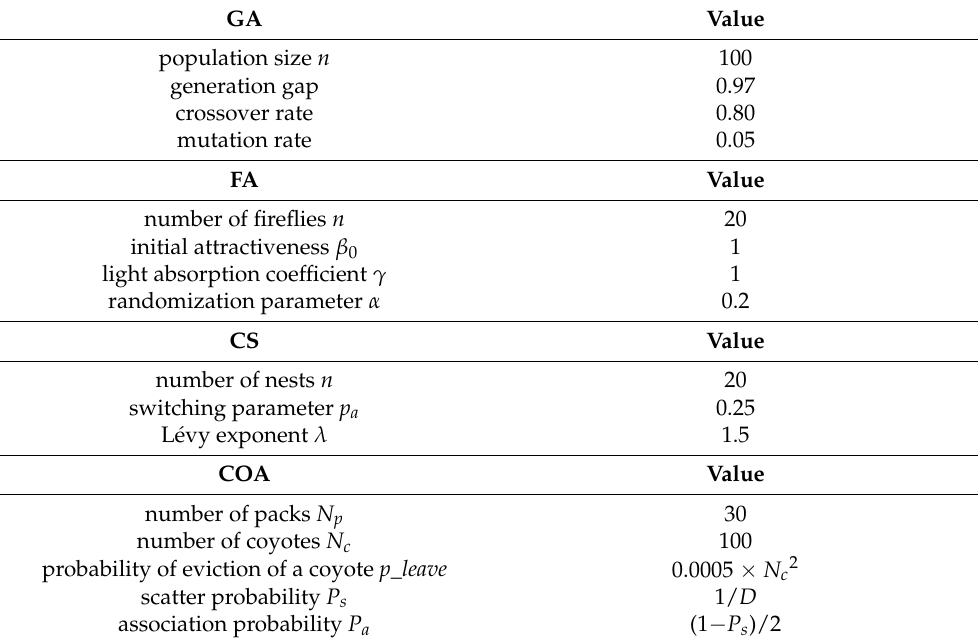
Table 1. The optimal values of the main parameters of the metaheuristic algorithms.